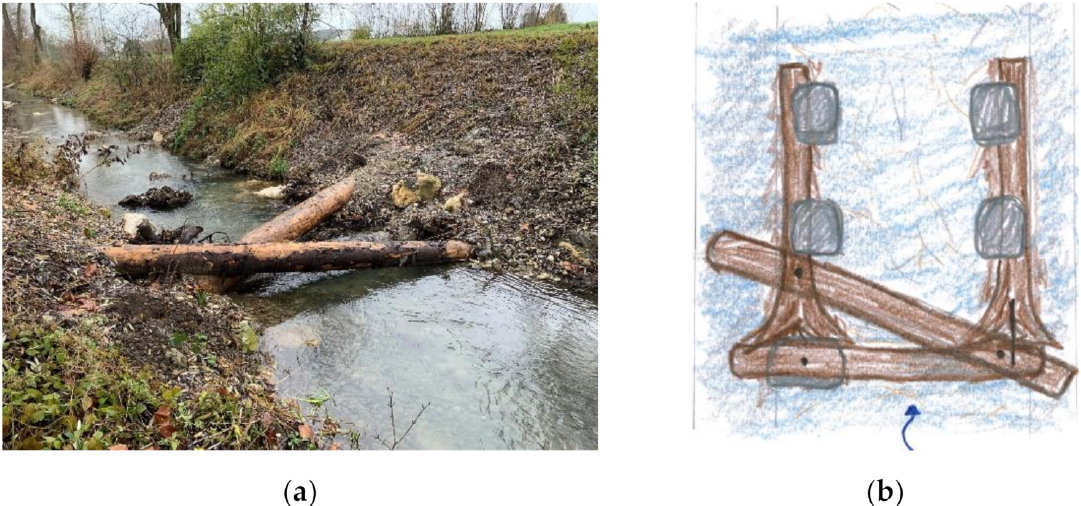
Figure 13. ( a ) Anchored LWS inducing a diving current; Witibach stream; Photo: V. Neuhaus. ( b ) Sketch of the built LWS; Witibach stream; IUB Engineering